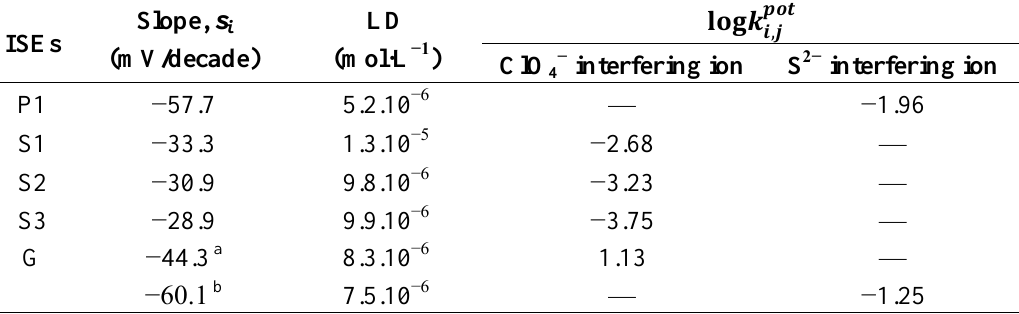
Table 2. Response characteristics of the ISEs forming the sensor